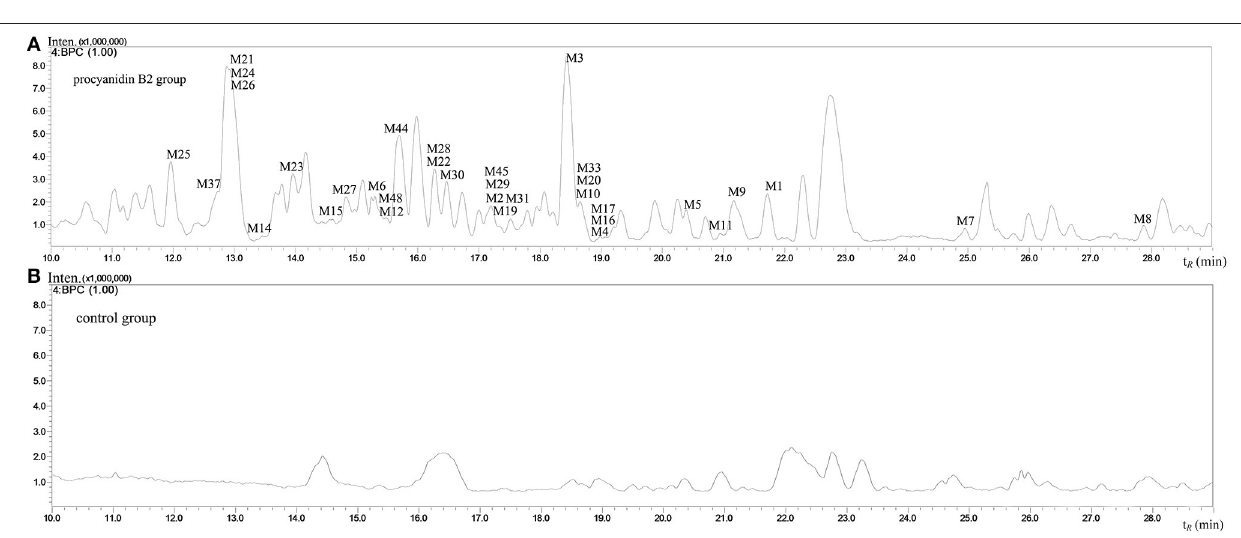
FIGURE 3 | The negative ion base peak chromatograms of mice urine. (A) The BPC of urine of Procyanidin B2 group; (B) The BPC of urine of control group.